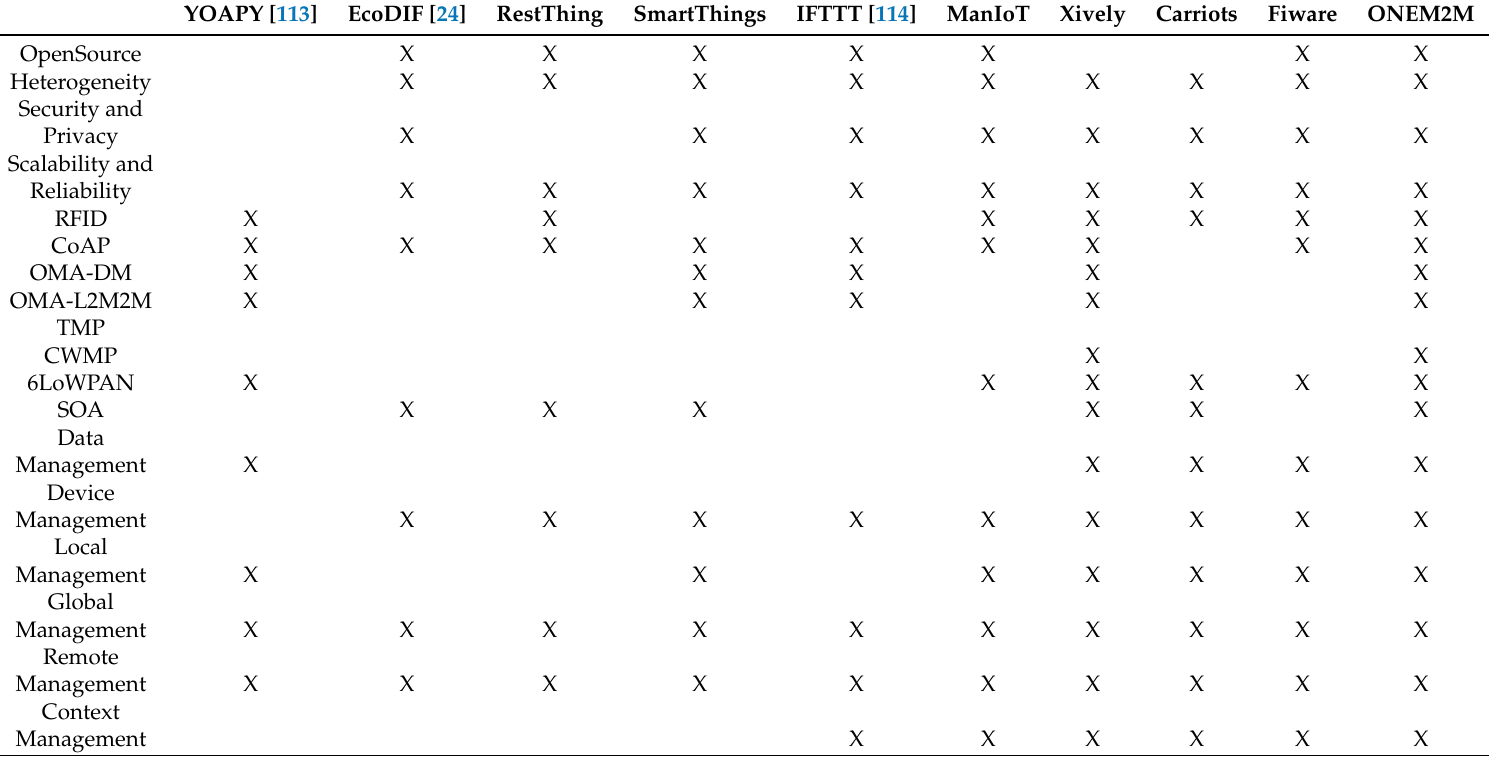
Table 8. Main characteristics comparison of the IoT Device Management